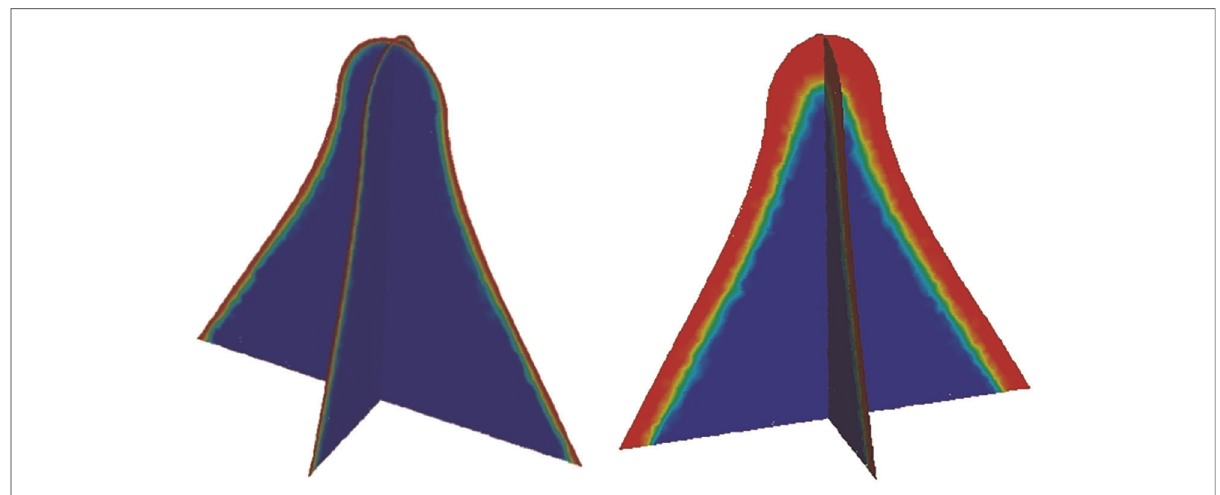
FIGURE 3 Volume fraction of secretion at different moments in the longitudinal and transverse sections of the spindle